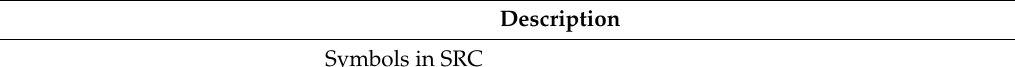
Table 1. Table of